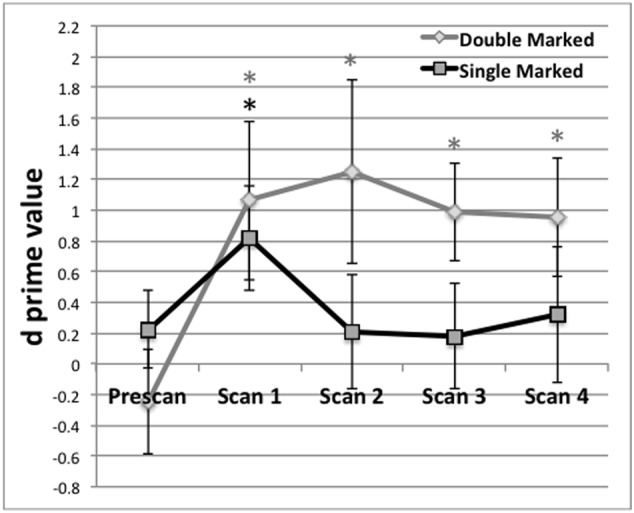
Behavioral performance (d prime) on test blocks administered before the first scan (Prescan) and after scans 1–4. Mean behavioral performance for Double (black) and Single Marked (gray) words. A black asterisk indicates recognition of Single Marked words was above chance performance. A gray asterisk indicates the same for Double Marked words. Error bars reflect the SEM.